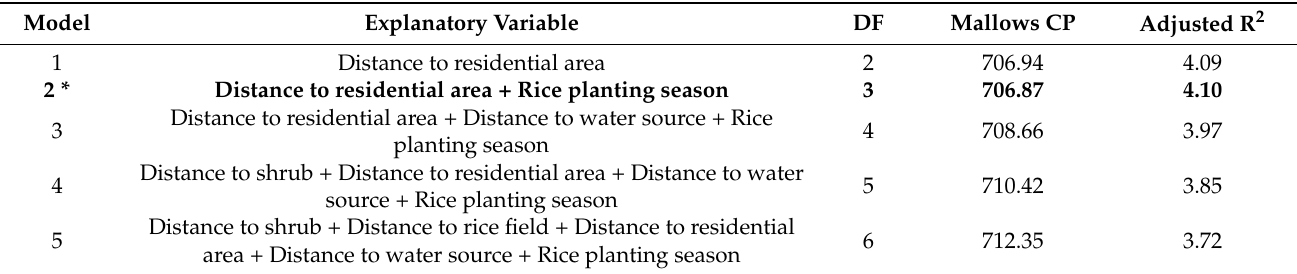
Table 6. Best subsets from candidate models using the dredging method. The most parsimonious model (labeled with * and bolded) has two landscape-level explanatory variables with the lowest Mallow Cp and highest adjusted R 2 influence to relative rodent